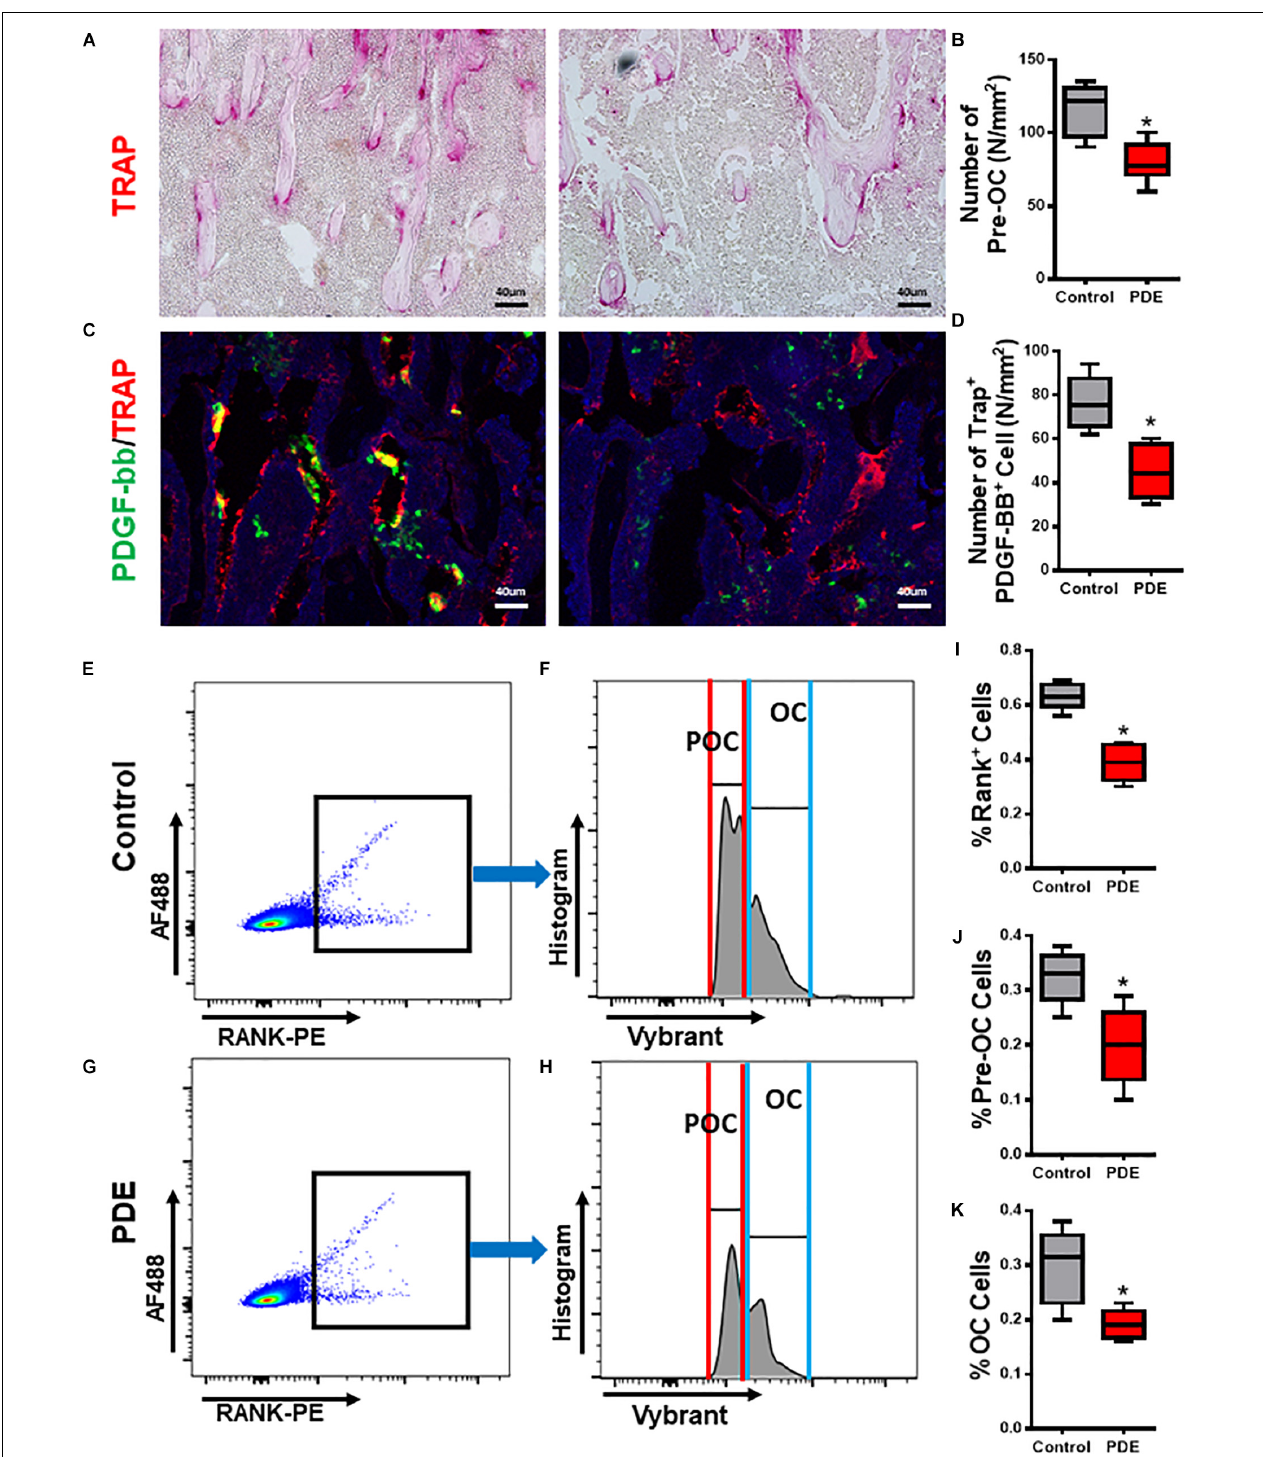
FIGURE 2 | Pre-osteoclast number and its synthesis of PDGF-BB decreased in ACT mice. (A,C) Representative TRAP staining (magenta) images (A) and immunofluorescence images of TRAP (red) and PDGF-BB (green) costaining (yellow) (C) in femoral metaphysis from 12-week-old female offspring. DAPI stains nuclei blue. Scale bar = 40 µ m. (B,D) Quantitative analysis of the N. POCs (B) and the N. TARP + PDGF-BB + cells (D) in distal femur. (E–H) Representative flow cytometry plots showing the sorting profile used to separate POCs and OCs in femoral bone from 12-week-old female mouse offspring. RANK + cells with 1-2 nuclei (POCs) and greater than three nuclei (OCs) are sorted for gene expression analysis. (I–K) Quantitative analysis of the percentage of RANK + cells (I) , POCs (J) , and OCs (K) in distal femur. * p < 0.05.